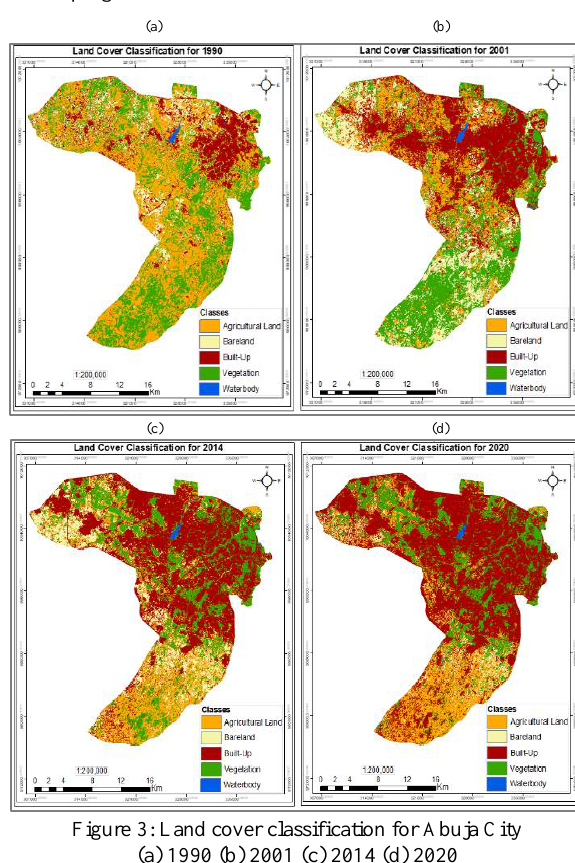
Figure 3: Land cover classification for Abuja City (a) 1990 (b) 2001 (c) 2014 (d) 2020